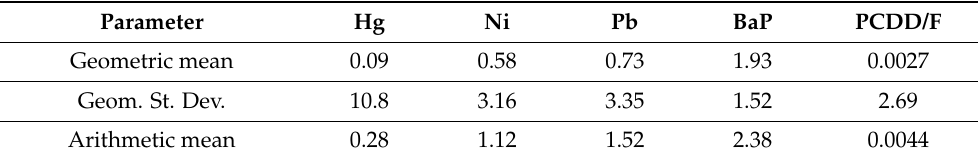
Table 2. Parameters of the fitted lognormal distributions for Hg, Ni, Pb, benzo(a)pyrene (BaP), and PCDD/F concentrations (Geometric and arithmetic mean: µ g m − 3 for Hg, Ni, Pb; ng m − 3 for BaP; ng I-TEQ m − 3 for PCDD/F; all concentrations referred at 0 ◦ C, 101.3 kPa, dry basis, 11% O 2 . Geometric standard deviation: dimensionless). Parameter Hg Ni Pb BaP PCDD/F Geometric mean 0.09 0.58 0.0027 Geom. St. Dev. Arithmetic